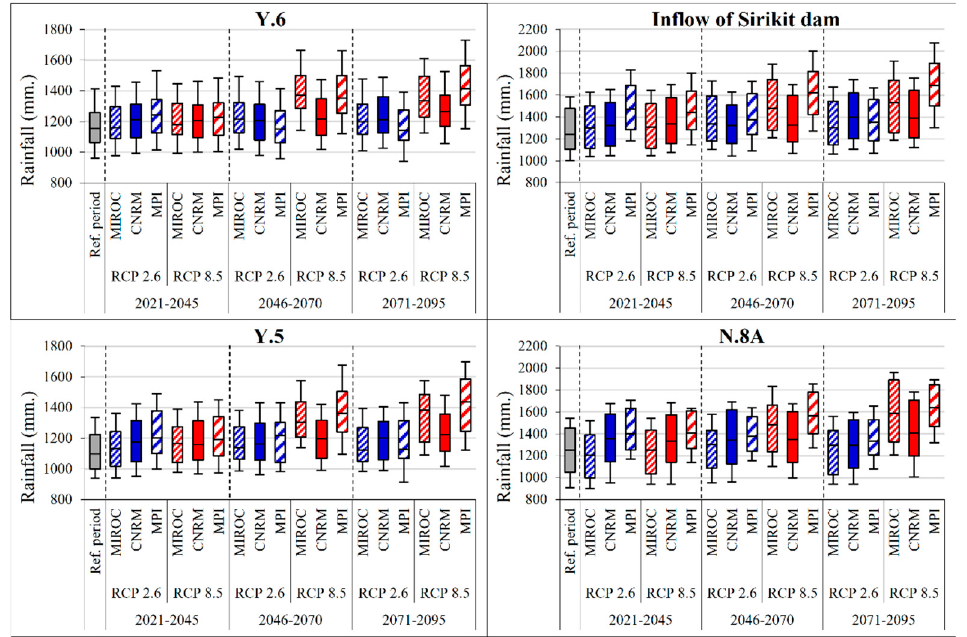
Figure 5. Annual rainfall in the reference period (1981–2005) with the near future, intermediate future, and far future under RCP 2.6 and RCP 8.5.